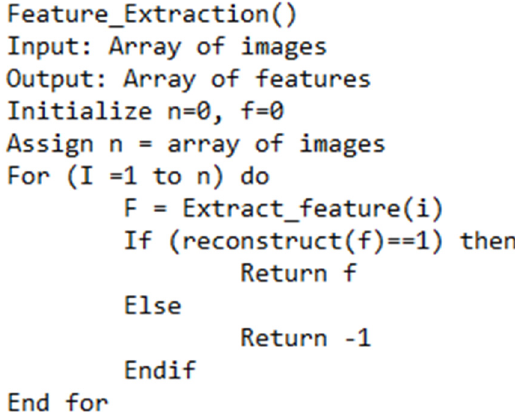
10 of 21 Figure 5. Fine-tuned DenseNet Architecture. Step 3.1: Pooling layer Two-dimensional filters are used to integrate the features in the area covered by the two-dimensional filter as it slides over each feature map channel. The dimension of the pooling layer output is in Equation (12): (𝐼 (cid:3035) − 𝑓 + 1)/𝑙 ∗ (𝐼 (cid:3050) − 𝑓 + 1)/𝑠 ∗ 𝐼 (cid:3030) (12) where 𝐼 (cid:3035) -the height of the feature map, 𝐼 (cid:3050) -width of the feature map, 𝐼 (cid:3030) -number of chan- nels in the map, f-filter size, l-stride length Step 3.2: Generating output Transfer learning is adopted to alter the architecture of DenseNet. Leaky ReLu is used as the activation function. The existing CNN includes are employed. GITHUB portal (https://github.com/titu1994/DenseNet accessed on 7 December 2021) is utilized to imple- ment the existing CNN architecture. The studies [10,18,21] are employed to evaluate the